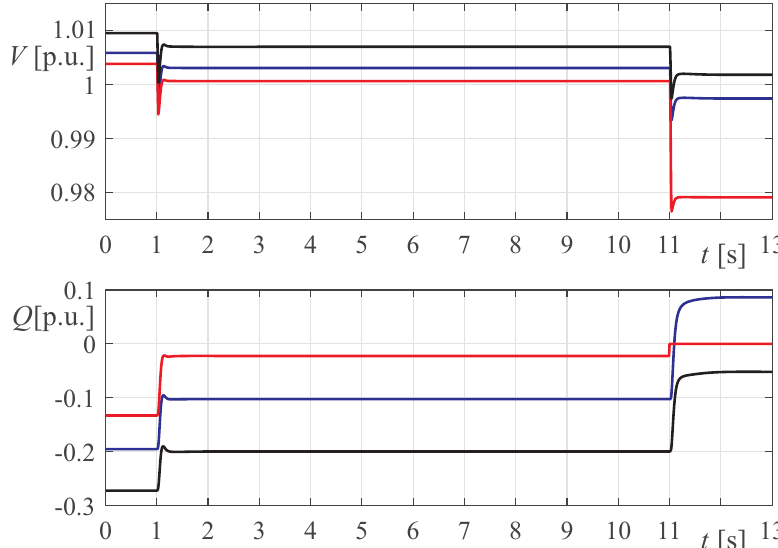
Figure 9. Second simulation, Feeder 1: time evolution of the nodal voltage amplitudes ( V 6 blue, V 11 red, V 13 black) and PV reactive powers ( Q DG